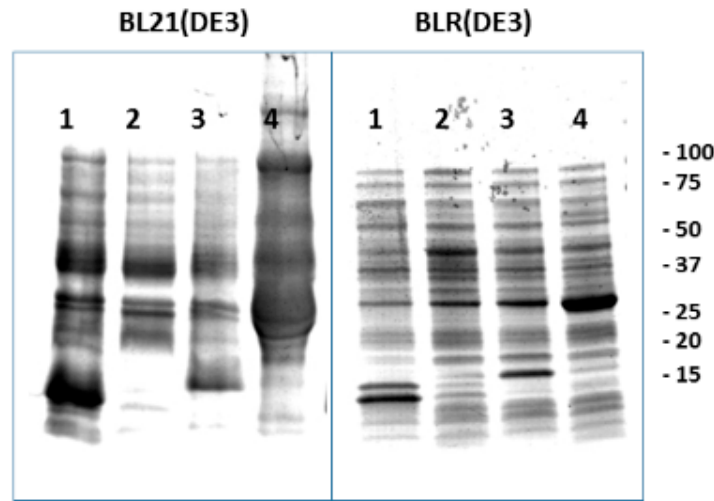
Figure 5. Coomassie-blue staining of polyacrylamide gel electrophoresed anchor-motif + frgC 91–220 spinycterins obtained in large amounts in BL21(DE3) and BLR(DE3) E. coli strains. E. coli coding for anchor-motif + GSGS + frgC 91–220 + GSGS + polyH recombinant proteins was